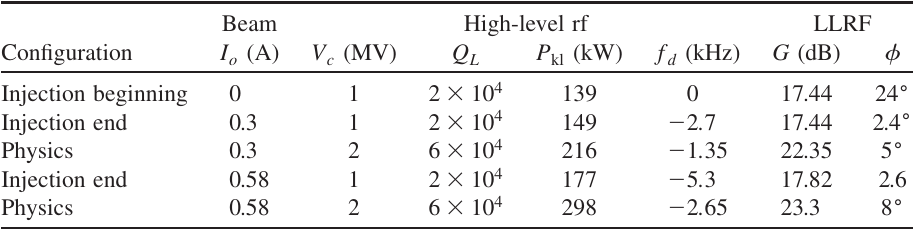
TABLE I. rf and LLRF parameters for beginning/end of injection and physics-collision configurations considered in this